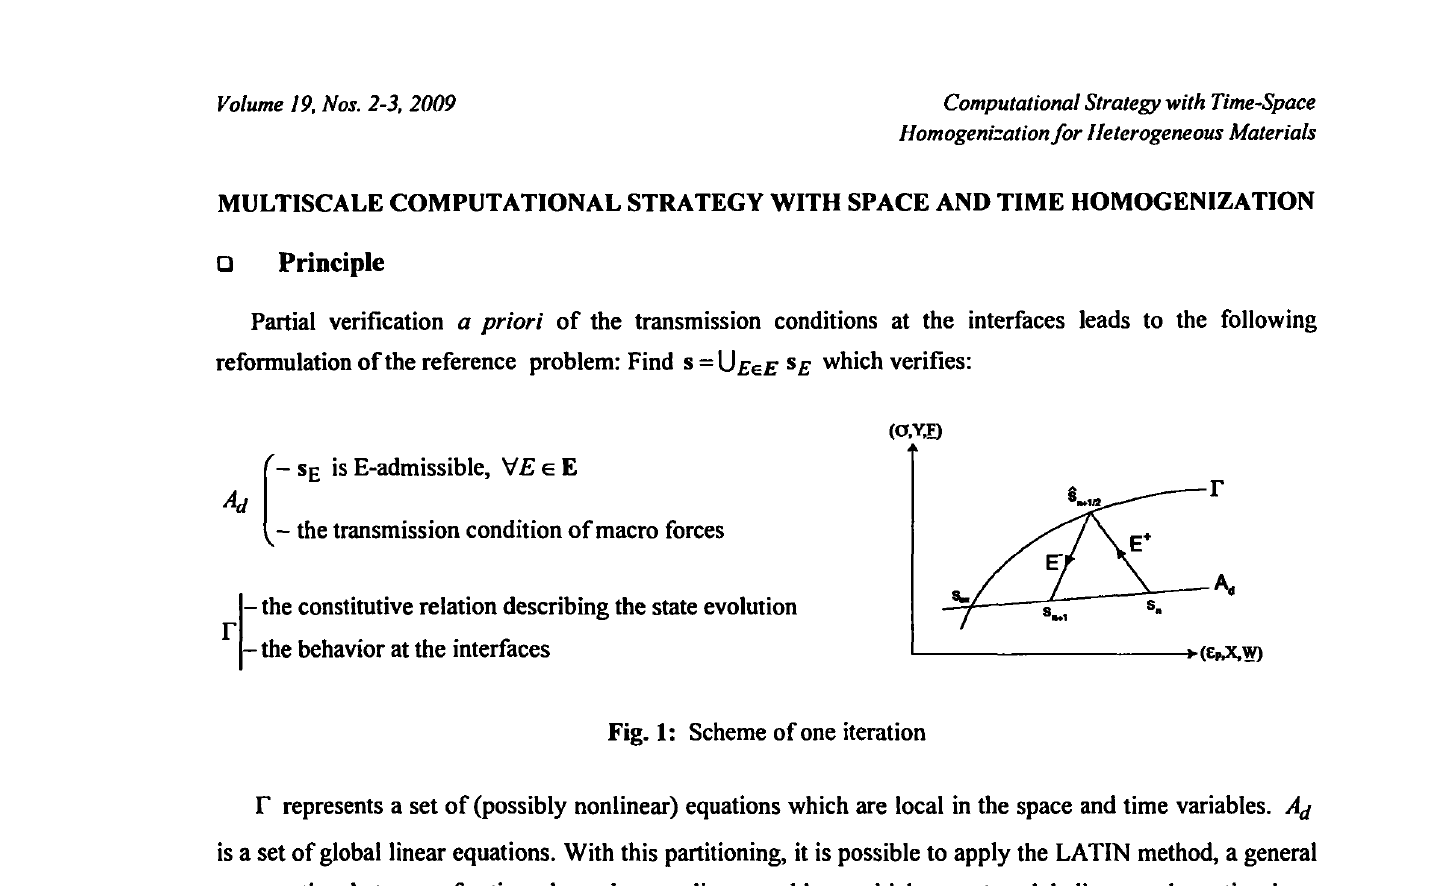
Fig. 1: Scheme of one